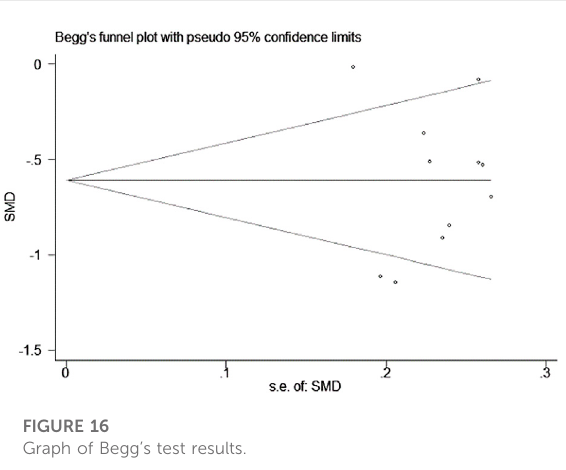
FIGURE 16 Graph of Begg ’ s test